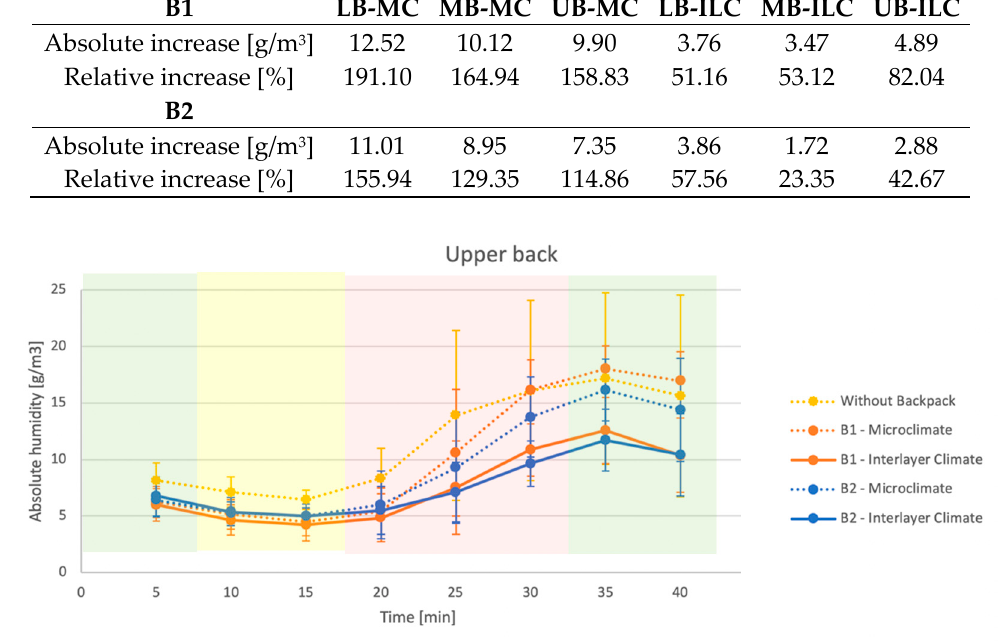
Figure 3. Mean values with standard deviation of the aH values at the UB in the MC without backpack (yellow-dotted), with B1 (orange-dotted) and B2 (blue-dotted) as well as in the ILC with B1 (orange- straight) and B2 (blue-straight). Acclimatization (green), walking at v = 4 km/h (yellow), walking at v = 4 km/h and 8% incline